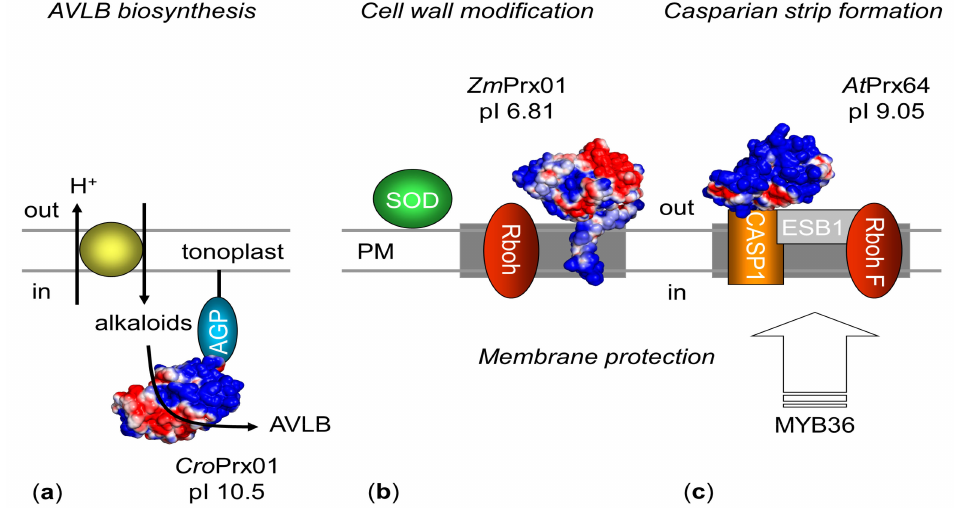
Figure 3. Membrane interaction and spatiotemporal organization of CroPrx01, ZmPrx01 and AtPrx64. ( a ) Soluble CroPrx01 interacts via an arabinogalactan protein (AGP, blue) with the inner surface of the tonoplast [35,67]. For α -3 (cid:48) ,4 (cid:48) -anhydrovinblastine (AVLB) synthesis, the complex